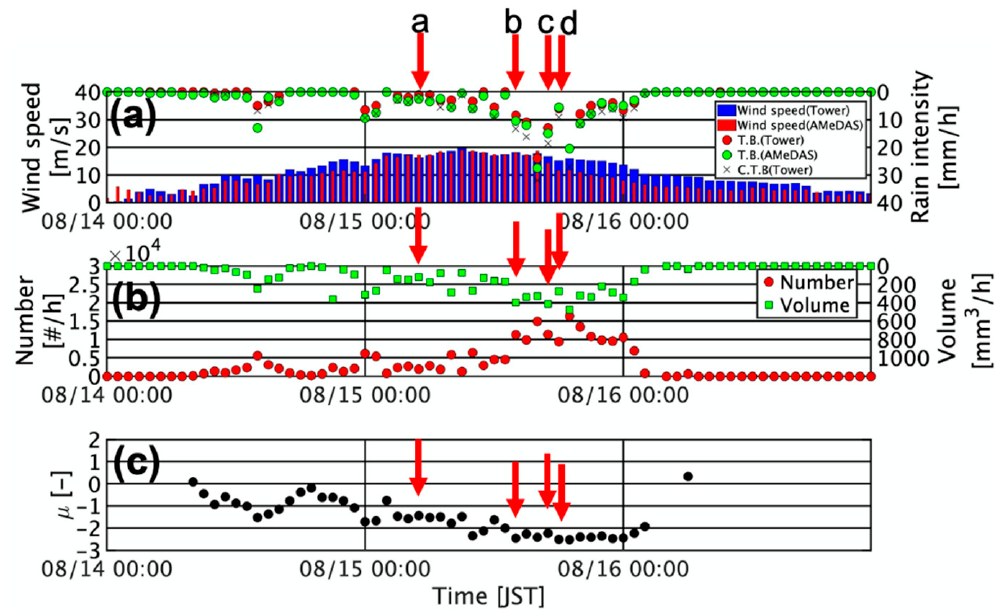
Figure 3. Time series of hourly wind speed and rainfall intensity (R tb , R ctb , and R AMe ), as well as the total number and volume of droplets and drop size distribution (DSD) shape parameter µ . ( a ) Wind speeds at the tower and AMeDAS station are expressed in blue and red bars, respectively. R tb and R ctb are shown in green dots and black crosses, respectively, and R AMe is in red dots. ( b ) Red circles indicate the total number of droplets detected by the SPC. Green squares indicate total volume of particles. ( c ) DSD shape parameter µ is shown. Arrows in (a–d) indicate the time points photographed in Figure 4.